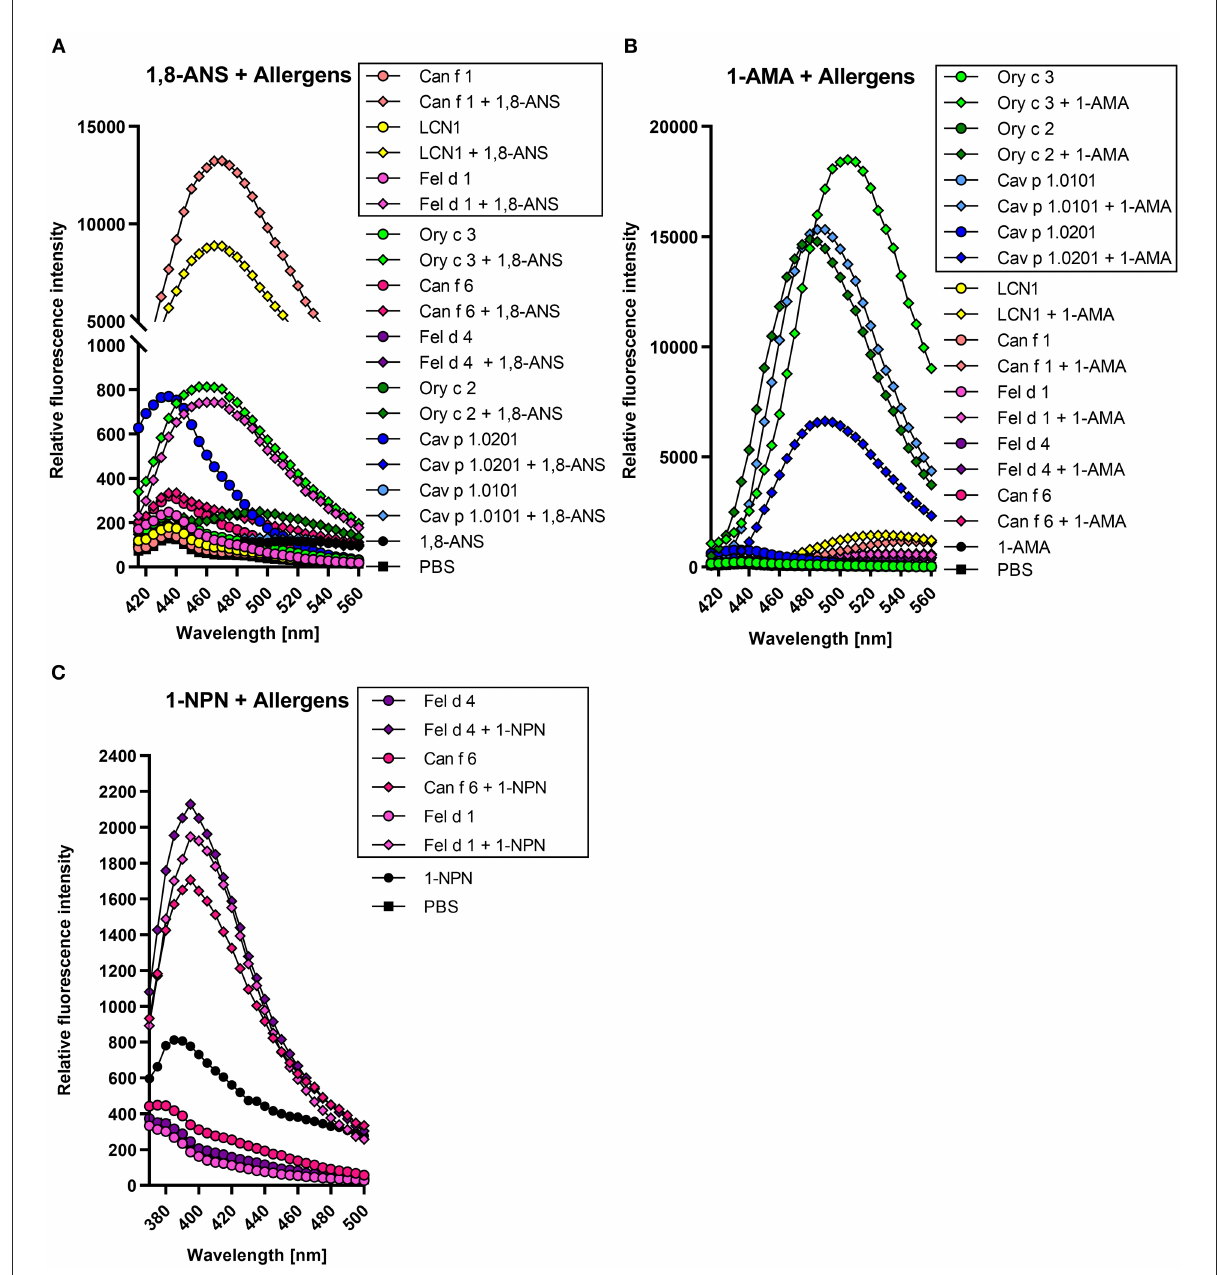
FIGURE4 Lipocalin and secretoglobin allergen-fluorochrome complexes emit high fluorescence intensities with protein specific emission maxima. Framed allergen-fluorochrome complexes are chosen for ligand competition assays based on their-signal-to-noise-ratio. Emission spectrum of 5 µ M allergen complexed with 5 µ M fluorochrome were recorded in duplicates between 420 and 560nm for (A) 1-AMA and (B) 1,8-ANS ( λ ex = 380nm) and between 380 and 500nm for (C) 1-NPN ( λ ex = 337nm).